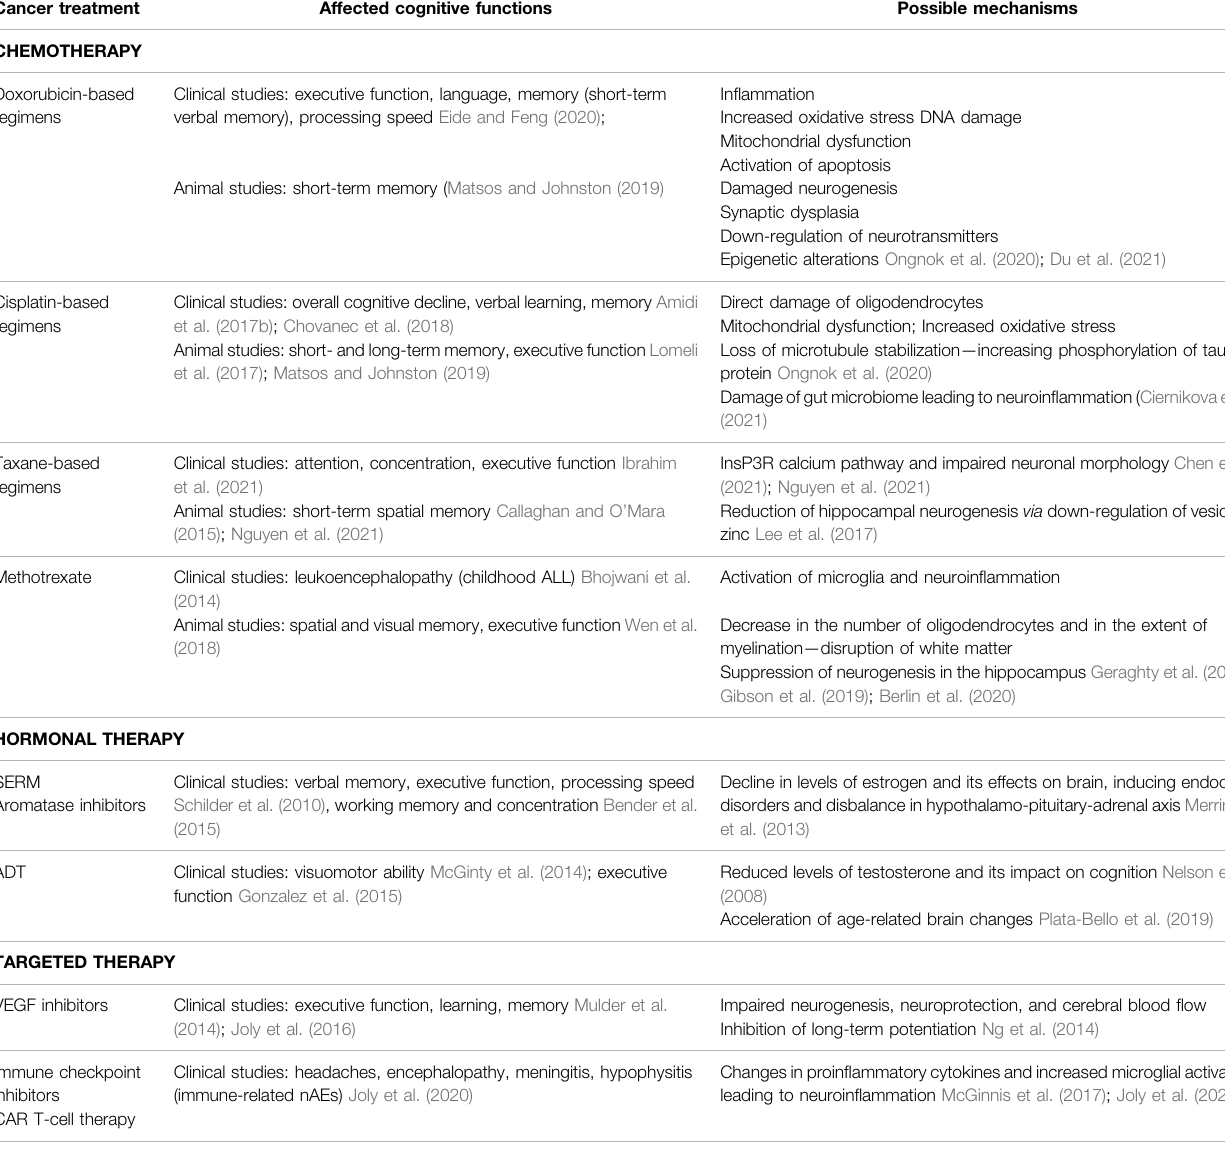
TABLE 1 | Selected cancer treatments and affected cognitive functions with associated possible mechanisms of CRCI. Cancer treatment Affected cognitive functions Possible